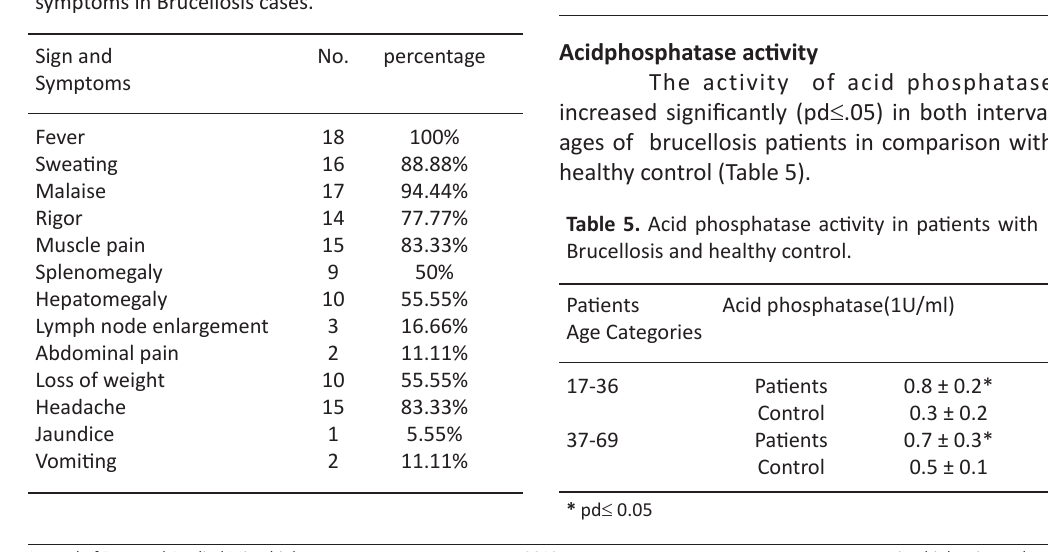
Table 2. Prevalence of different clinical sign and symptoms in Brucellosis cases.